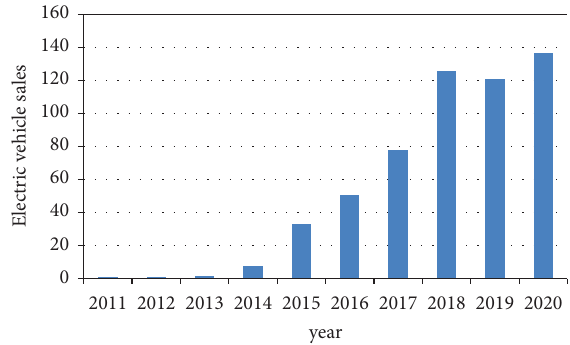
Figure 1: Annual sales volume of EVs in China from 2011 to 2020 (unit: